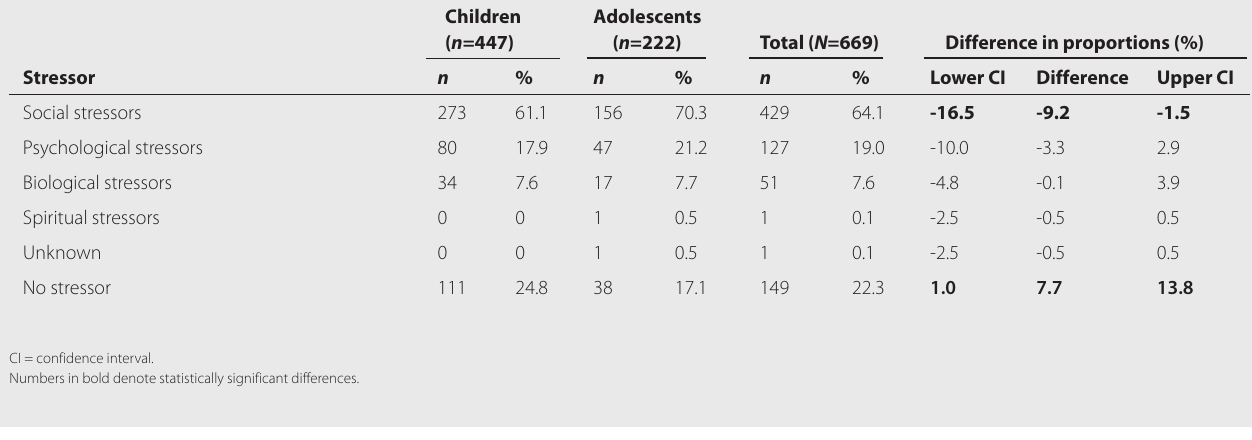
Table 4. Stressors identified in children and adolescents diagnosed with mental health problems